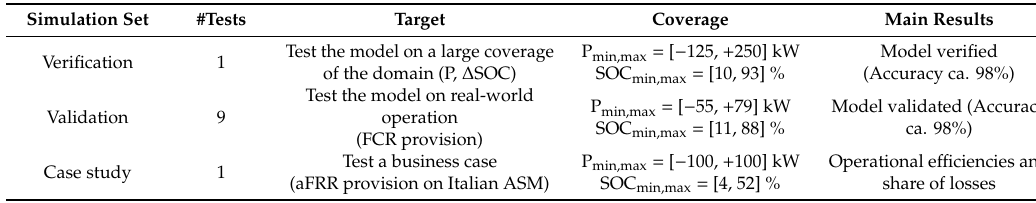
Table 14. Overall summary of performed